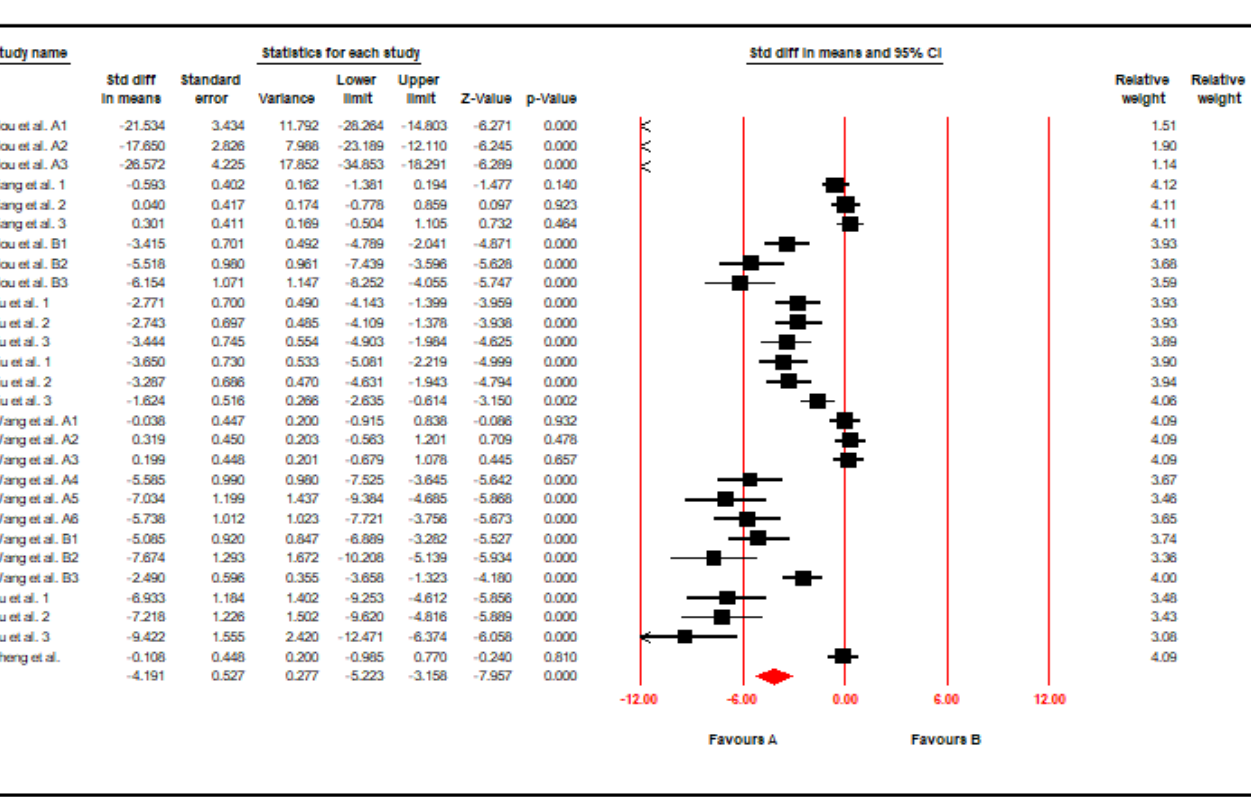
Figure 2. Forest plot of decreasing Serum MDA (SMD, − 4.19; 95% CI, − 5.22 to − 3.15; p < 0.001; I 2 = 93.67%). Black solid square indicated the individual study’s SMD and the red solid square indicated the polling SMD of the included studies.Serum SOD